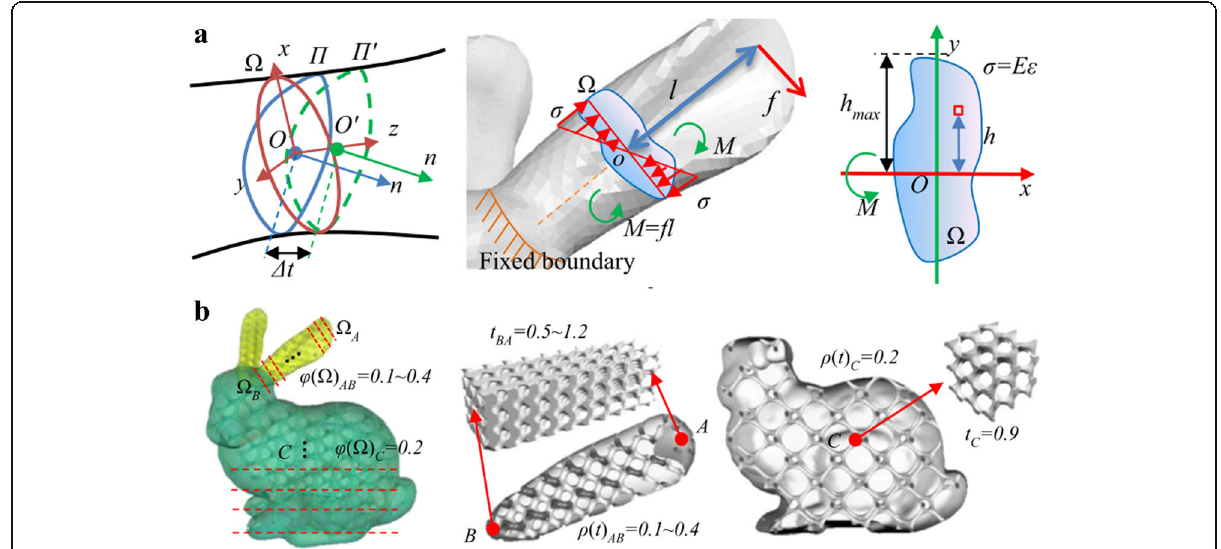
Fig. 5 Density-variable Lightweight structure design: a Cross section analysis. b Infill porous structures with Gyroid structures [20]